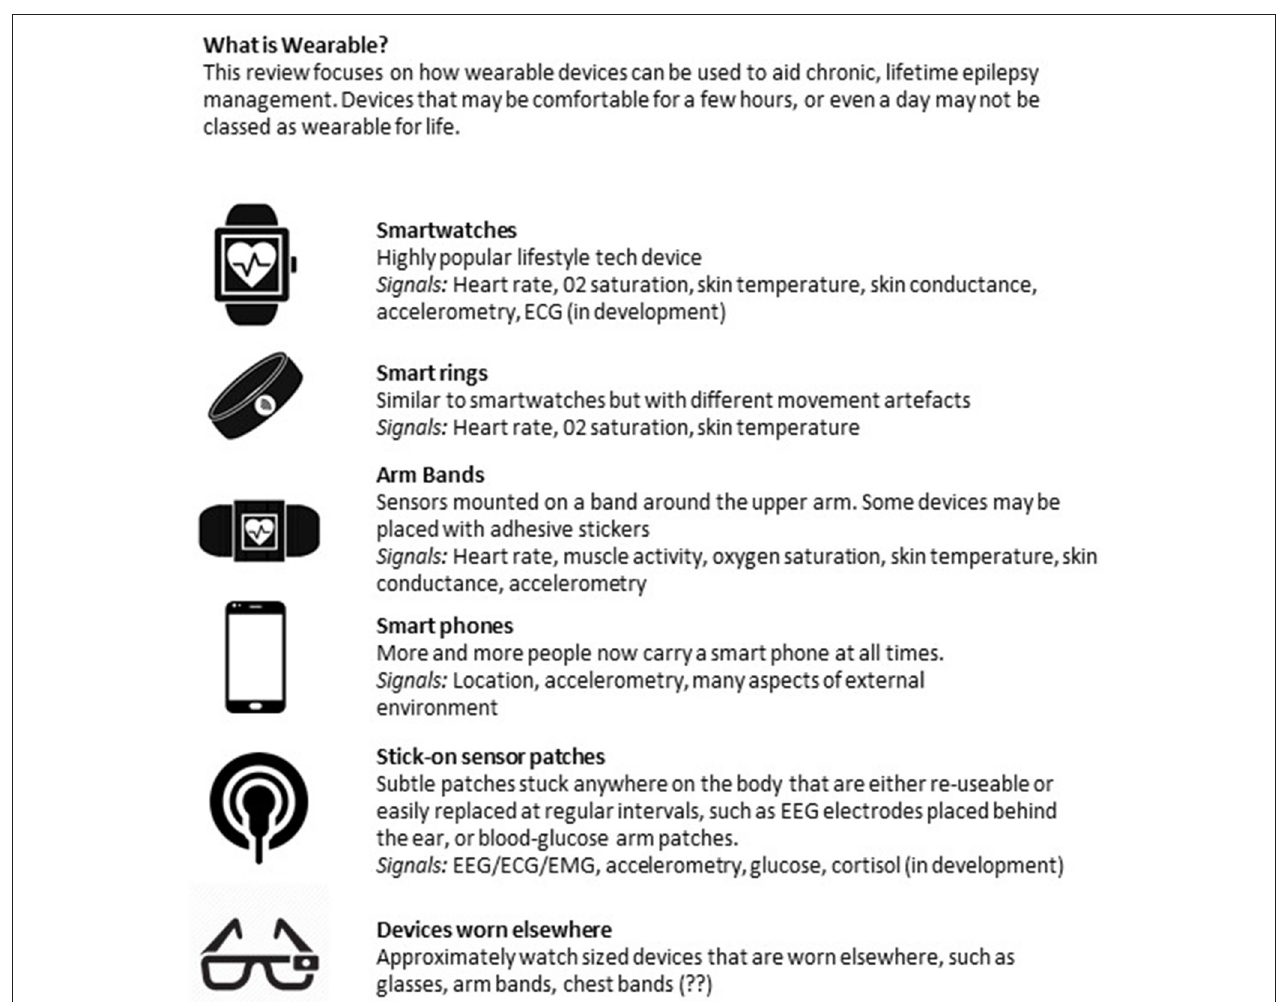
FIGURE 4 | Overview of wearable devices in